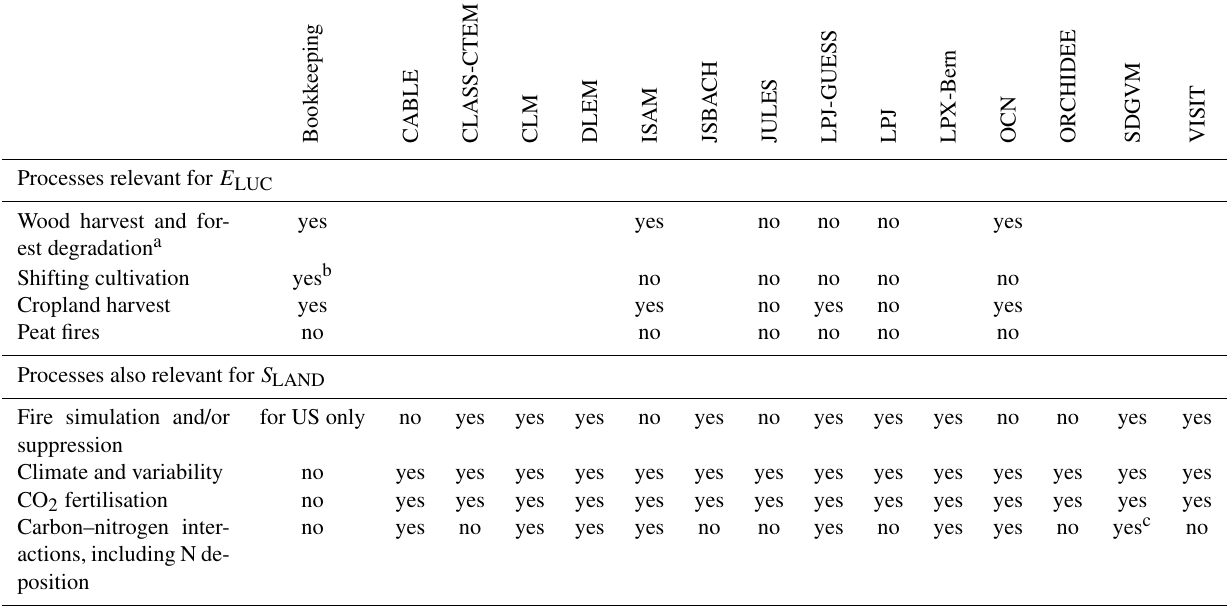
Table 5. Comparison of the processes included in the bookkeeping method and DGVMs in their estimates of E LUC and S LAND . See Table 6 for model references. All models include deforestation and forest regrowth after abandonment of agriculture (or from afforestation activities on agricultural land). Processes relevant for E LUC are only described for the DGVMs used with land-cover change in this study (Fig. 6 top